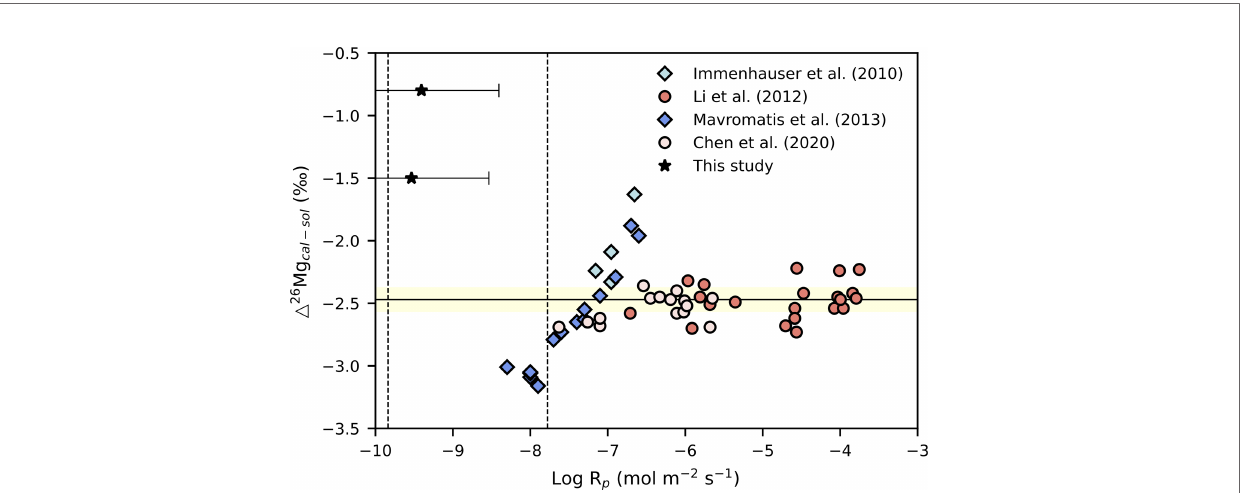
FIGURE 6 | Cross-plot of D 26 Mg cal-sol versus calcite precipitation rate (Log R p ). The dashed line represents the range of precipitation rates of seep carbonates (Karaca et al., 2010). A factor of 0.4 was also applied to data from literature to convert Ca fl uxes to carbonate precipitation rates (for details see Rates of Carbonate Precipitation and Mg Isotope Composition ). The estimated equilibrium D 26 Mg cal-sol value of − 2.47 ± 0.09 ‰ from literature at 25°C is represented by the solid line and yellow error envelope (Chen et al., 2020). Note that ϵ values in this study are plotted in the fi gure to describe the fractionation of Mg isotopes and to allow for comparison with D 26 Mg cal-sol values obtained from